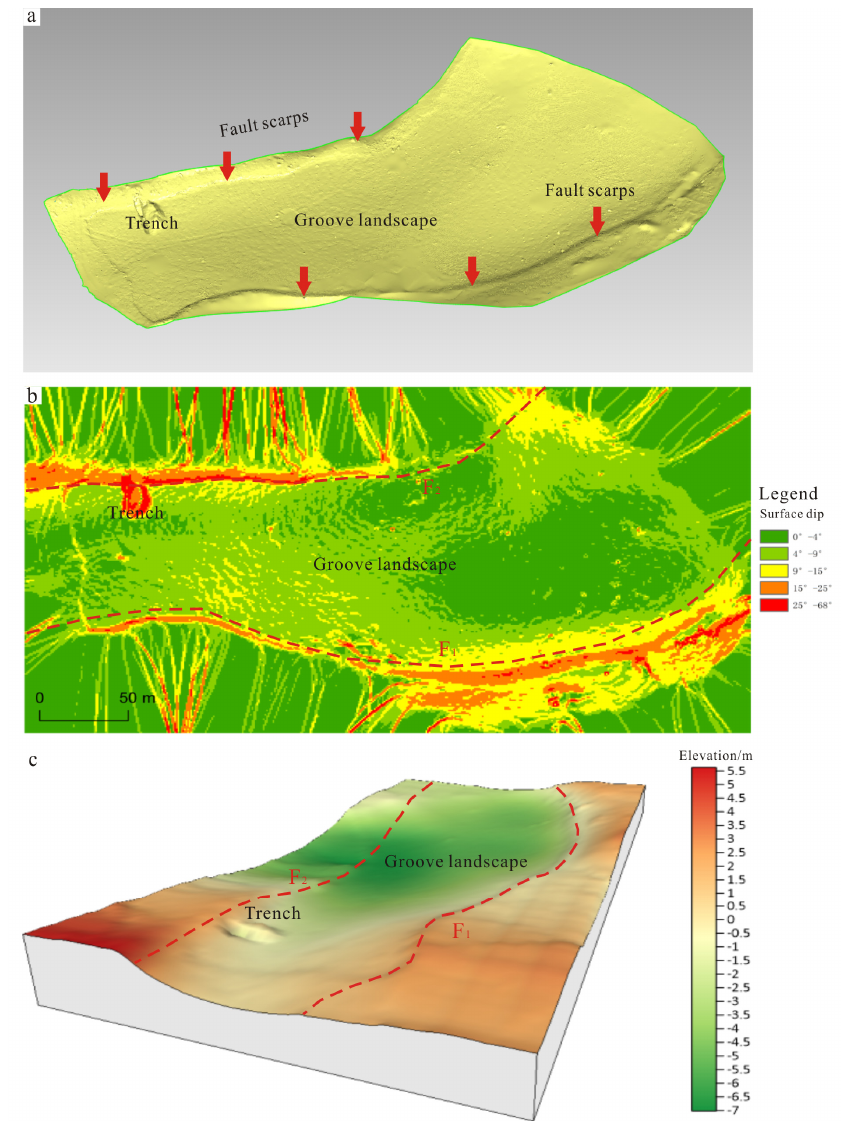
Figure 6. TLS results. ( a ) DEM. Red arrows represent fault scarps. ( b ) Surface slope map. Red dotted lines show fault traces at the surface. Green represents the surface dip angle of ~0–9°. Red indicates the surface dip angle of ~15°–68°. ( c ) 3D sur fi cial model.